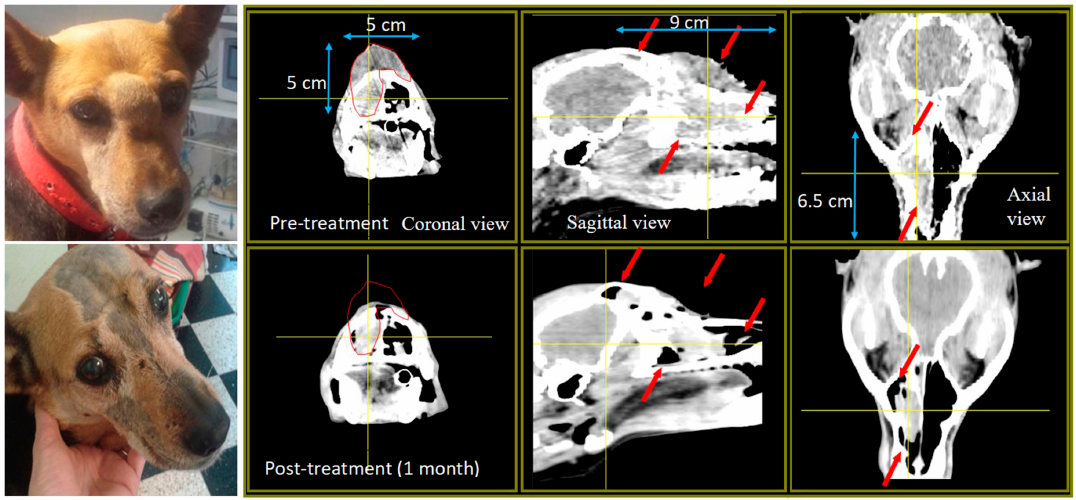
Figure 2. CT scan for Lucy pre-BNCT (top panel) and 1 month post BNCT (lower panel).